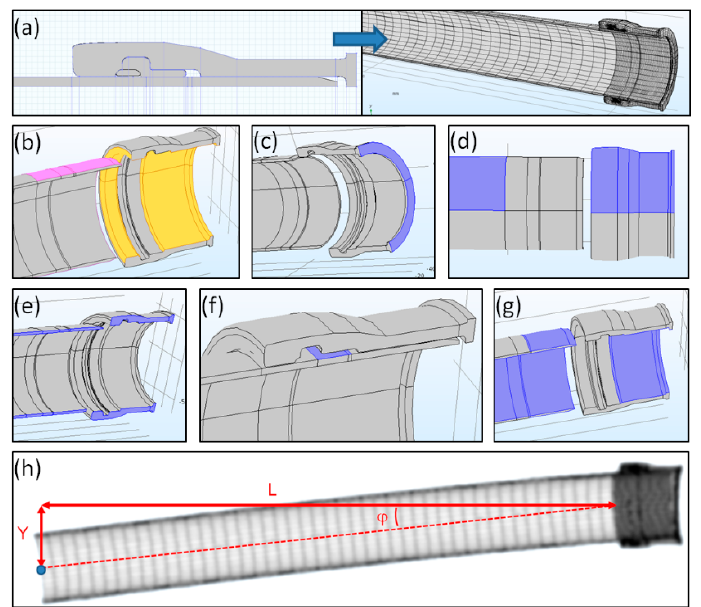
Figure 1. ( a ) The simulated geometry was constructed by rotating the blueprint provided by the PVC producer 180° around the pipe axis. ( b ) Contact between pipe and coupling is modeled with a contact pair boundary condition. ( c ) The coupling is kept in place with a fixed constraint boundary condition. ( d ) Soil load is modeled as a force per area, in combination with a corresponding normal force on the opposite surfaces (not shown). ( e ) The half system is completed with a symmetry boundary condition. ( f ) The coupling’s rubber seal is modeled as a spring foundation boundary condition. ( g ) The water pressure is modeled as a force per area inside the pipe, and inside the part of the coupling behind the rubber seal. ( h ) An angular deflection, defined as ϕ = tan − 1 (Y/L) is imposed on the system by applying